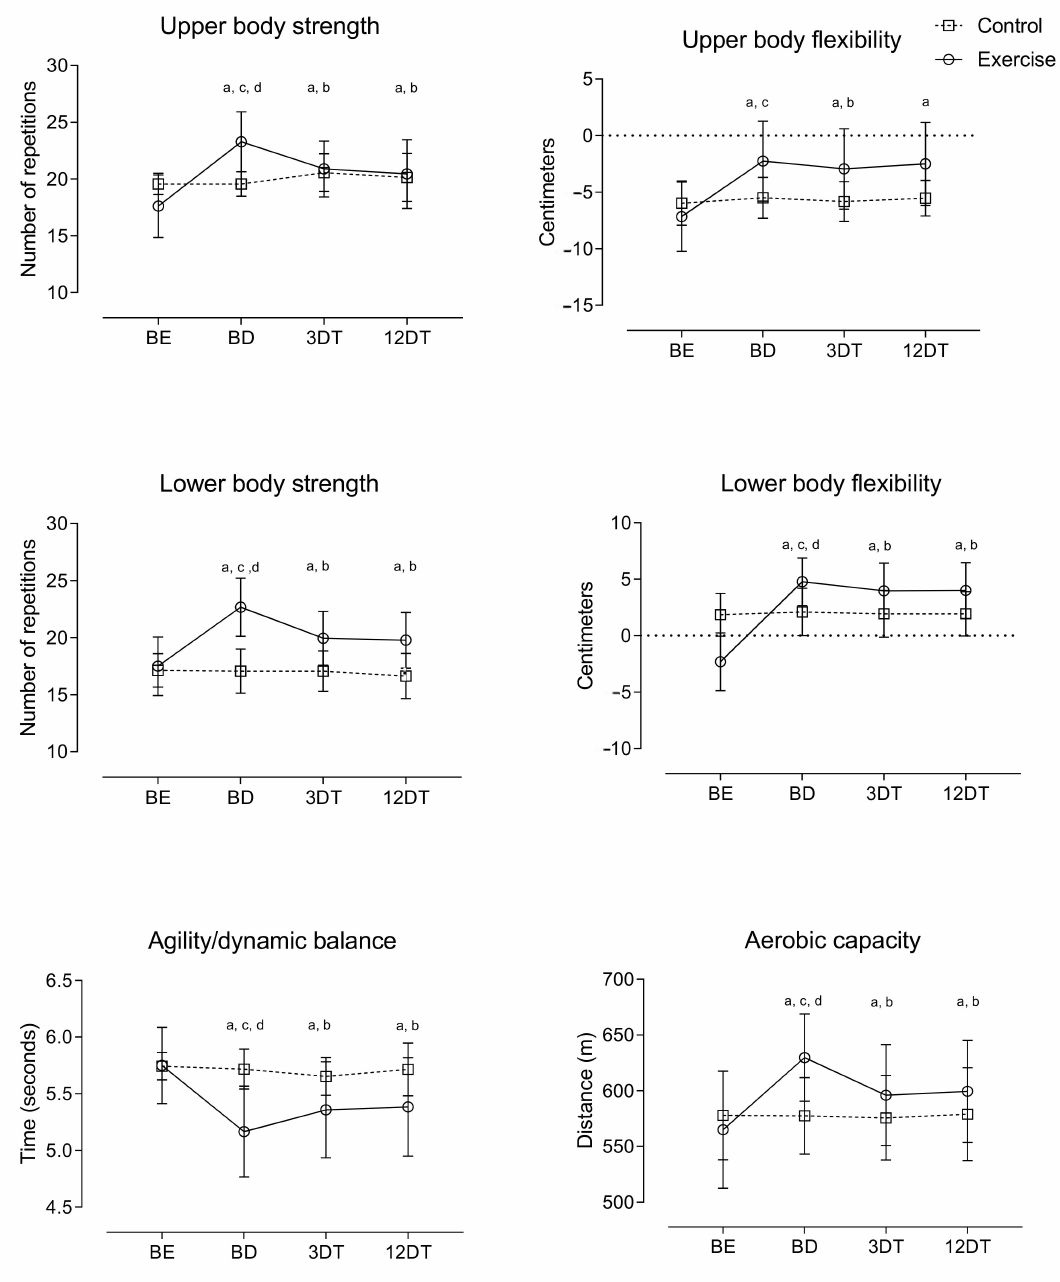
Figure 2. Relative changes in functional capacity during the METP and the DT period; baseline (BE), after METP (BD), after three months of DT (3DT) and after 12 months of DT (12DT); a p < 0.05, significant difference between BEs for METP; b p < 0.05, significant difference between BDs for METP; c p < 0.05, significant difference between 3DTs for METP; d p < 0.05, significant difference between 12DTs for